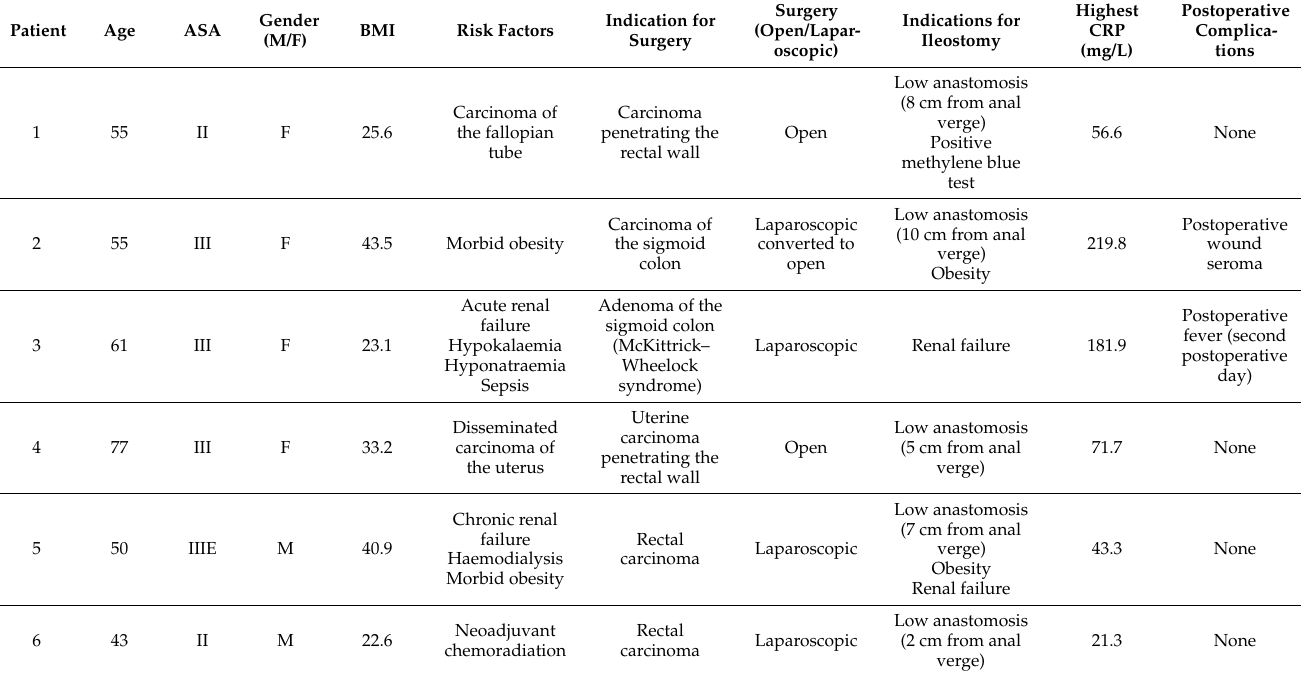
Table 1. Detailed patients, surgery, and outcomes